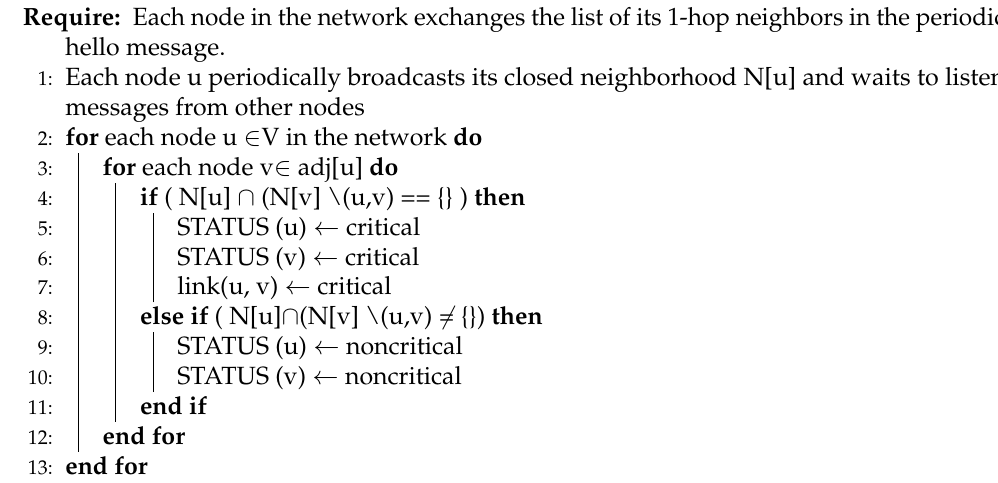
Algorithm 1 computes critical nodes/links based on the localized knowledge avail-